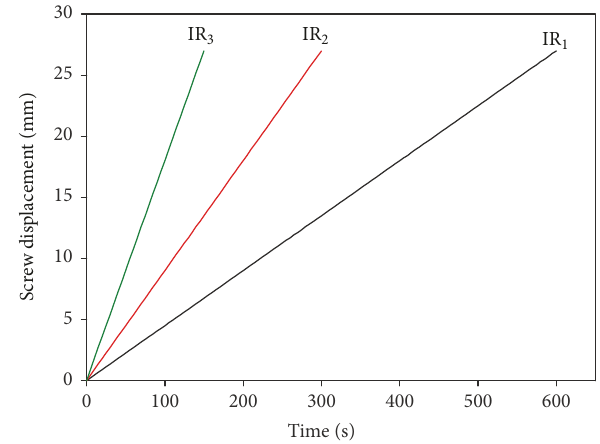
Figure 2: Influence of screw displacement on injection flow rates regularity: 0.150 mL ⋅ min −1 (IR 1 ), 0.300 mL ⋅ min −1 (IR 2 ), and 0.600 mL ⋅ min −1 (IR 3